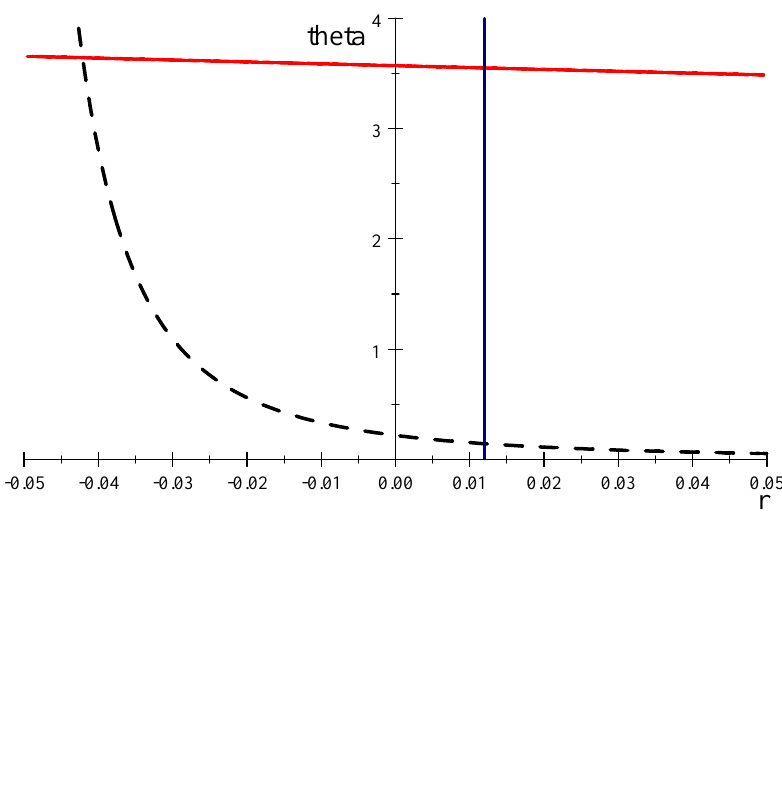
Figure 11: Changes of labour market tightness with respect to the real interest rate: